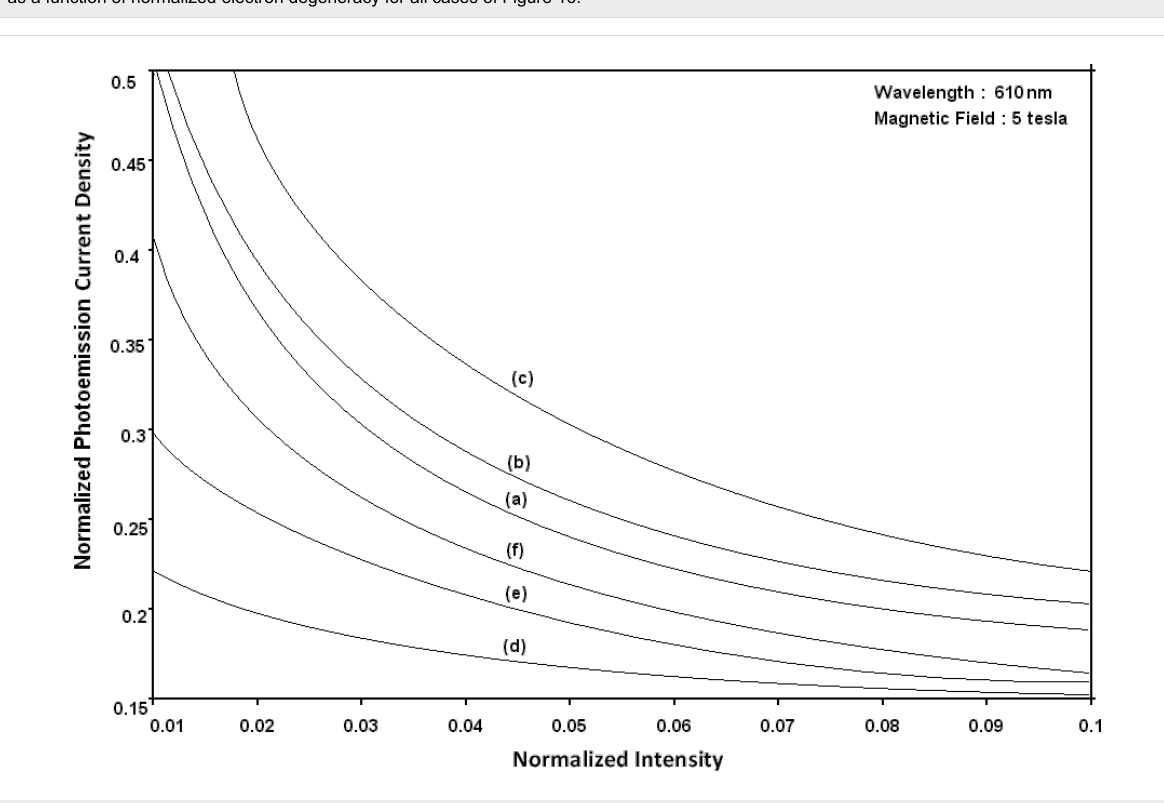
Figure 18: Plot of the normalized magneto photoemission current density from effective mass superlattices of HgTe/Hg 1 − x Cd x Te and In x Ga 1 − x As/InP as a function of normalized intensity for all cases of Figure